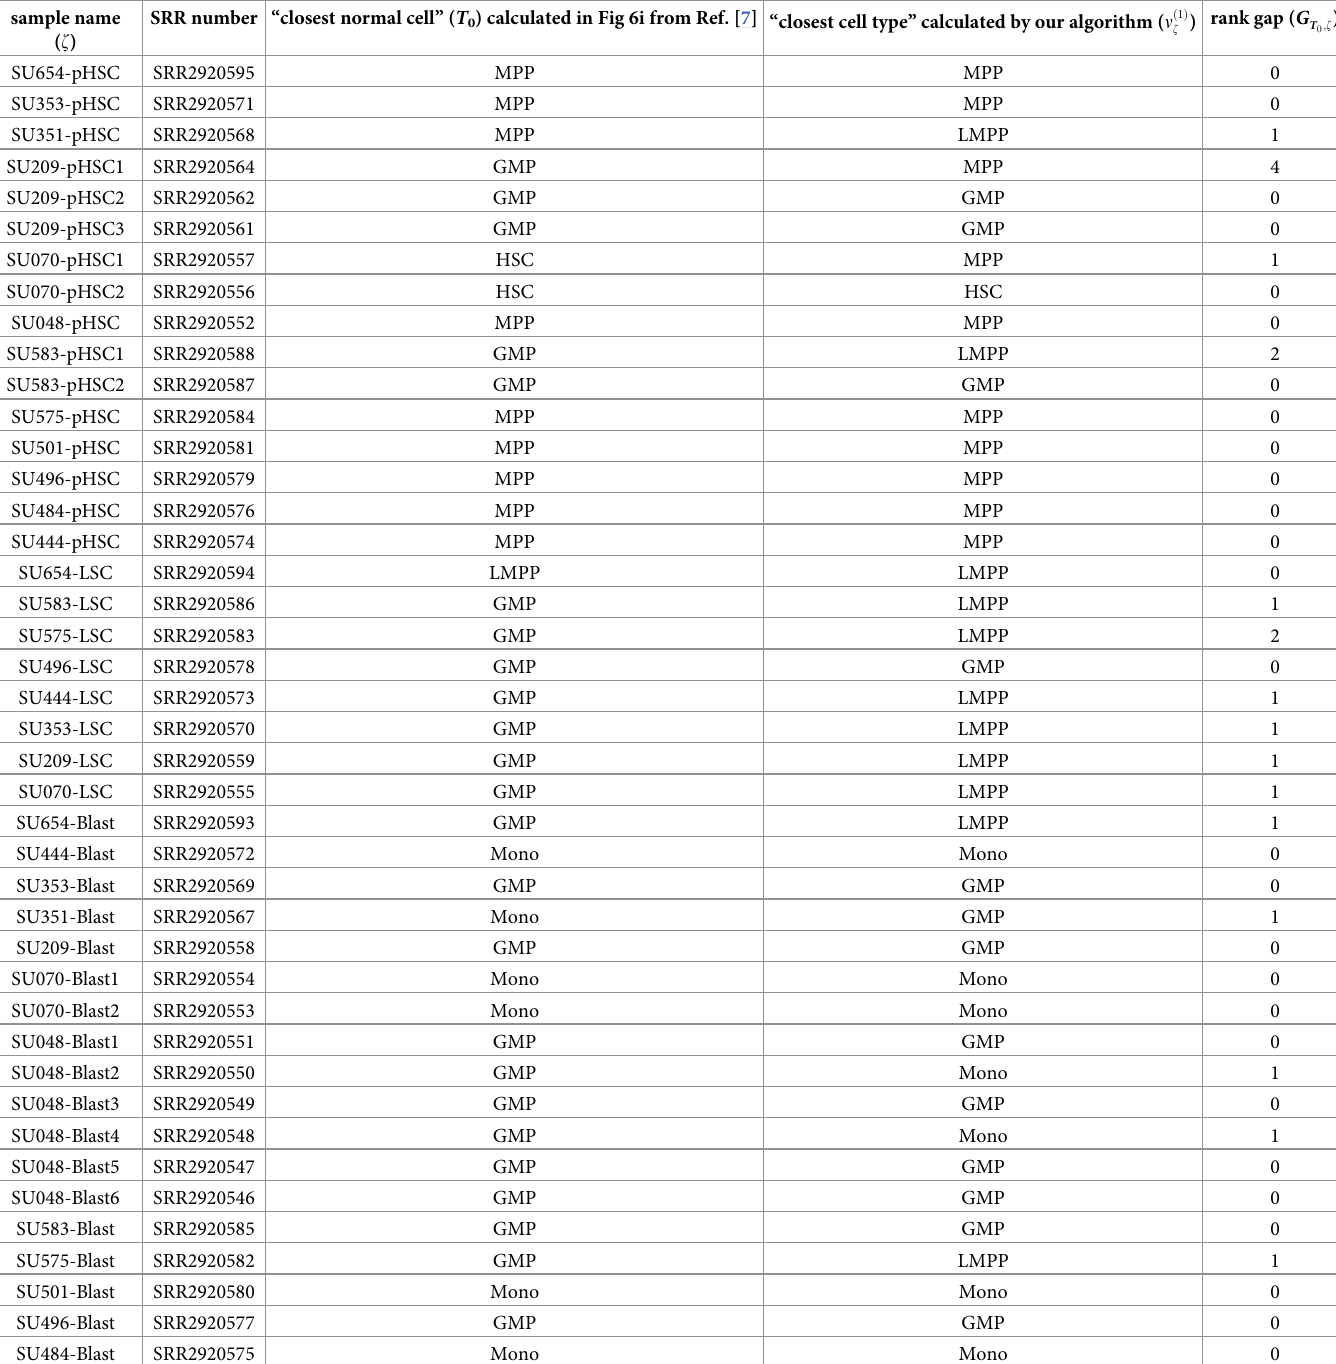
Table 4. Classification of ATAC-seq data of AML samples. Comparison between the “closest normal cell” in Fig 6i of [7] and “closest cell type” computed by our algo- rithm. The second, the third, and ... -th “closest type” were also identified by our algorithm. The “rank gap” represents the difference of the result between the two analyti- cal methods. For example, the “closest normal cell” of sample SU351-pHSC is MPP in [7], but is LMPP by our algorithm. “MPP” was the second “closest cell type”. Thus, the rank gap was calculated as 2-1 (= 1). If the results from the two analytical methods coincide with each other, the rank gap is